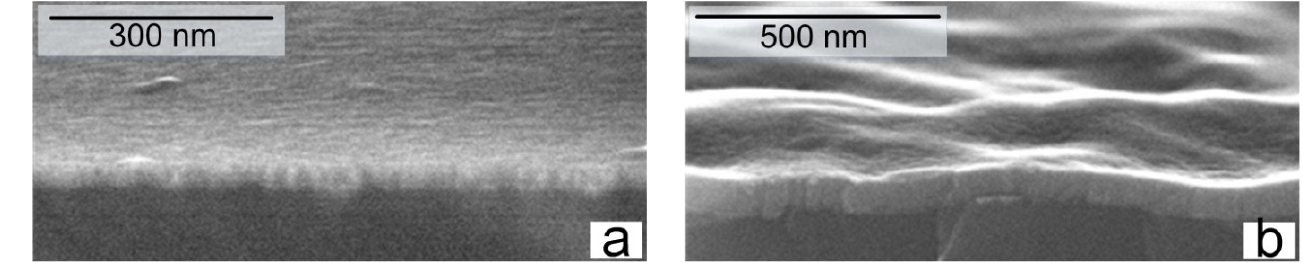
Figure 1. The initial Cr film ( a ) and CrSi 2 film ( b ) obtained by RTT Cr at 400 °C.